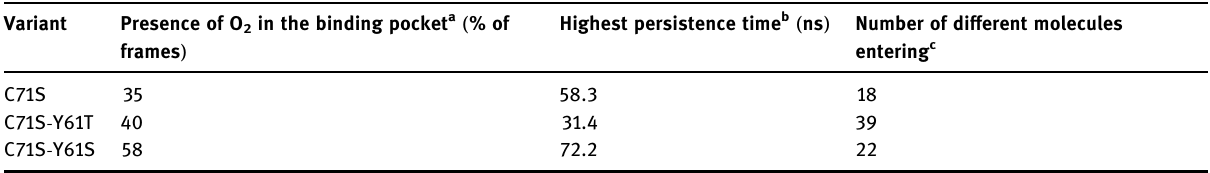
Table 1: Presence and persistence of O 2 molecules in the binding pocket Variant Presence of O 2 in the binding pocket a ( % of